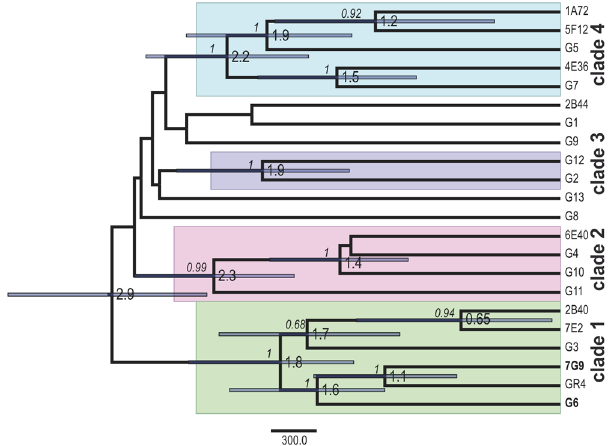
Figure 1. Genealogy of the 21 isolates representative of genomic variation within the S. meliloti GR4- type population. The maximum clade credibility tree was estimated with BEAST 2 25 , from the alignment (Supplementary Data 1) of concatenated genes carrying SNPs from the chromosome, pSymB and pSymA replicons (280,068 nts) of all isolates, as previously determined within the GR4-type population 22 . Node bars indicate the 95% credibility intervals (95% HPD) for node age, and posterior probabilities ( > 0.5) are indicated (in italics) on the branches. The estimated node ages (indicating the branching time in thousands of years ago) and the phylogenetically supported clades are indicated. Isolates carrying the GID are indicated in bold